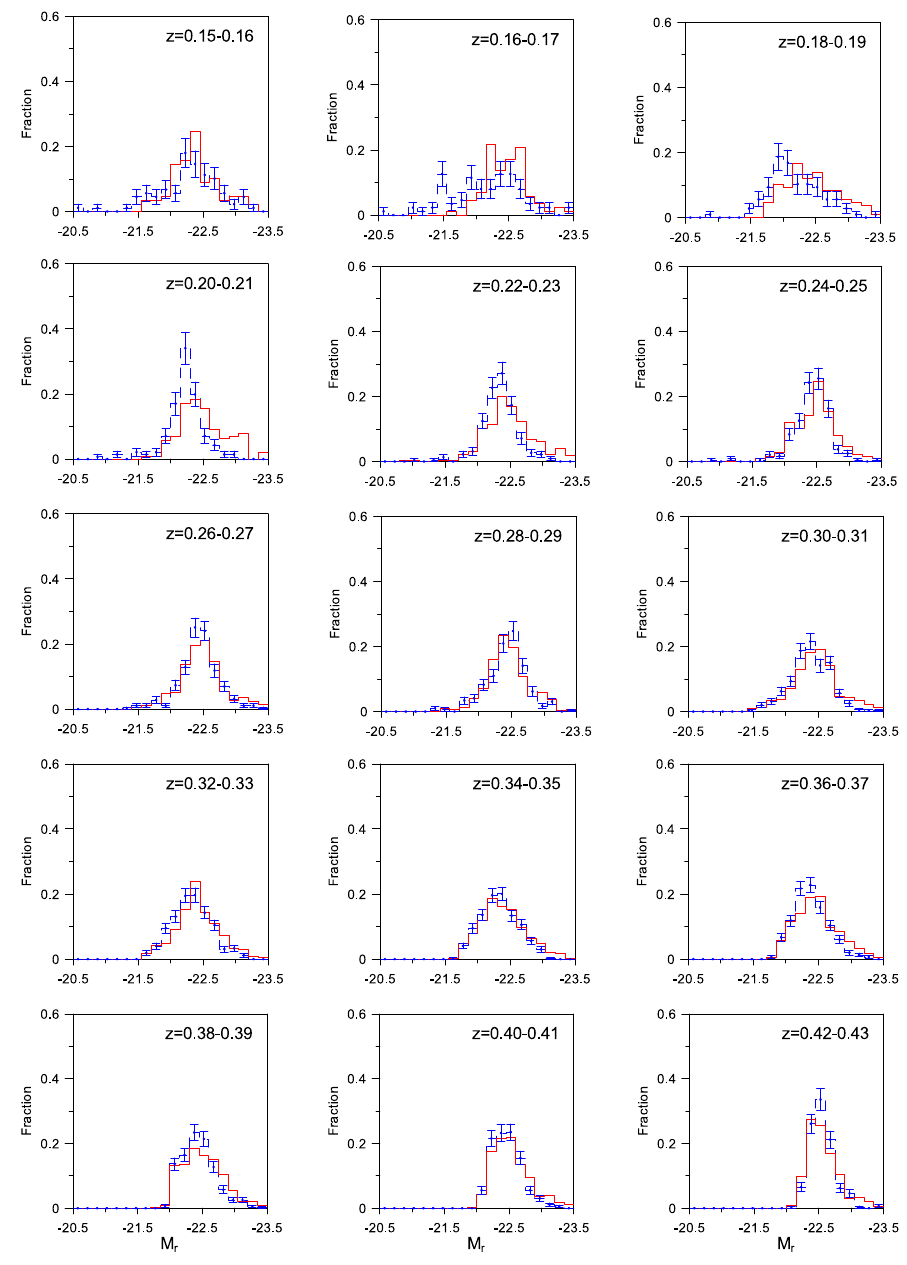
Fig. 3. Same as Fig. 1, but for the r -band absolute magnitude distribution at both density extremes in different redshift